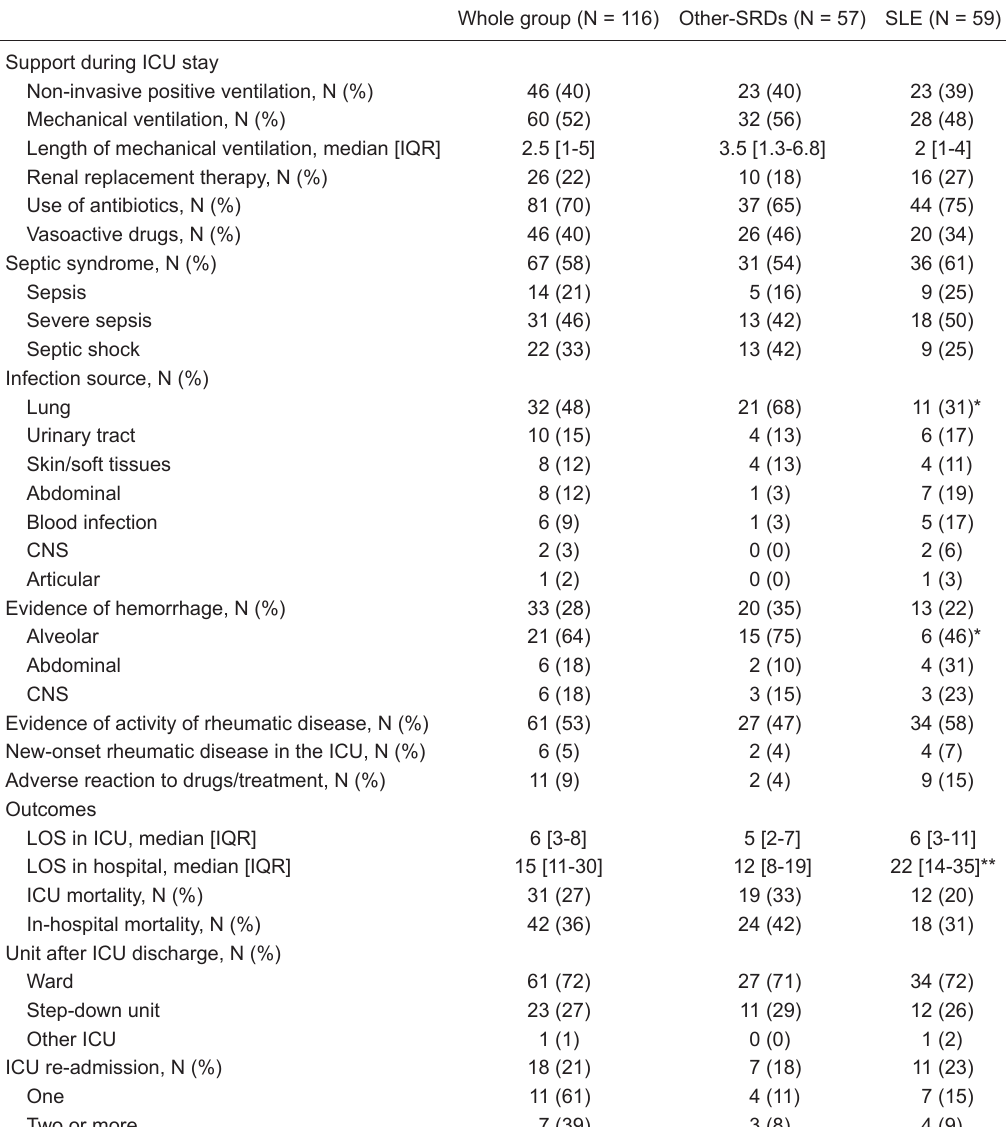
Table 3. Patient support in the ICU, secondary diagnosis and